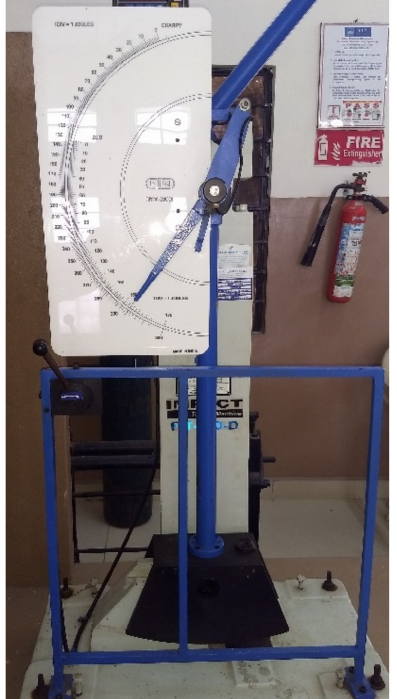
Figure 11. FIT-300-D model impact